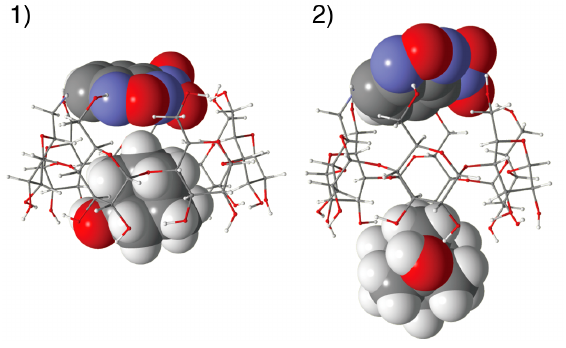
Figure 13. Estimated structure of ( 1 ) the NC0 β CD/1-AdOH and ( 2 ) NC0 α CD / 1-AdOH complex.